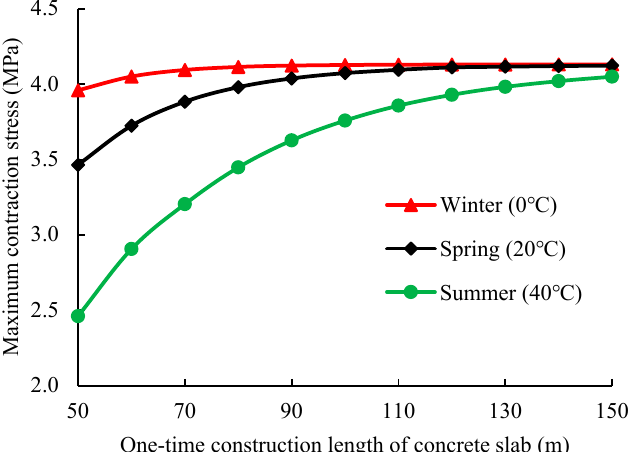
Figure 15. Maximum contraction in concrete slab with separator layer before sawing joints.